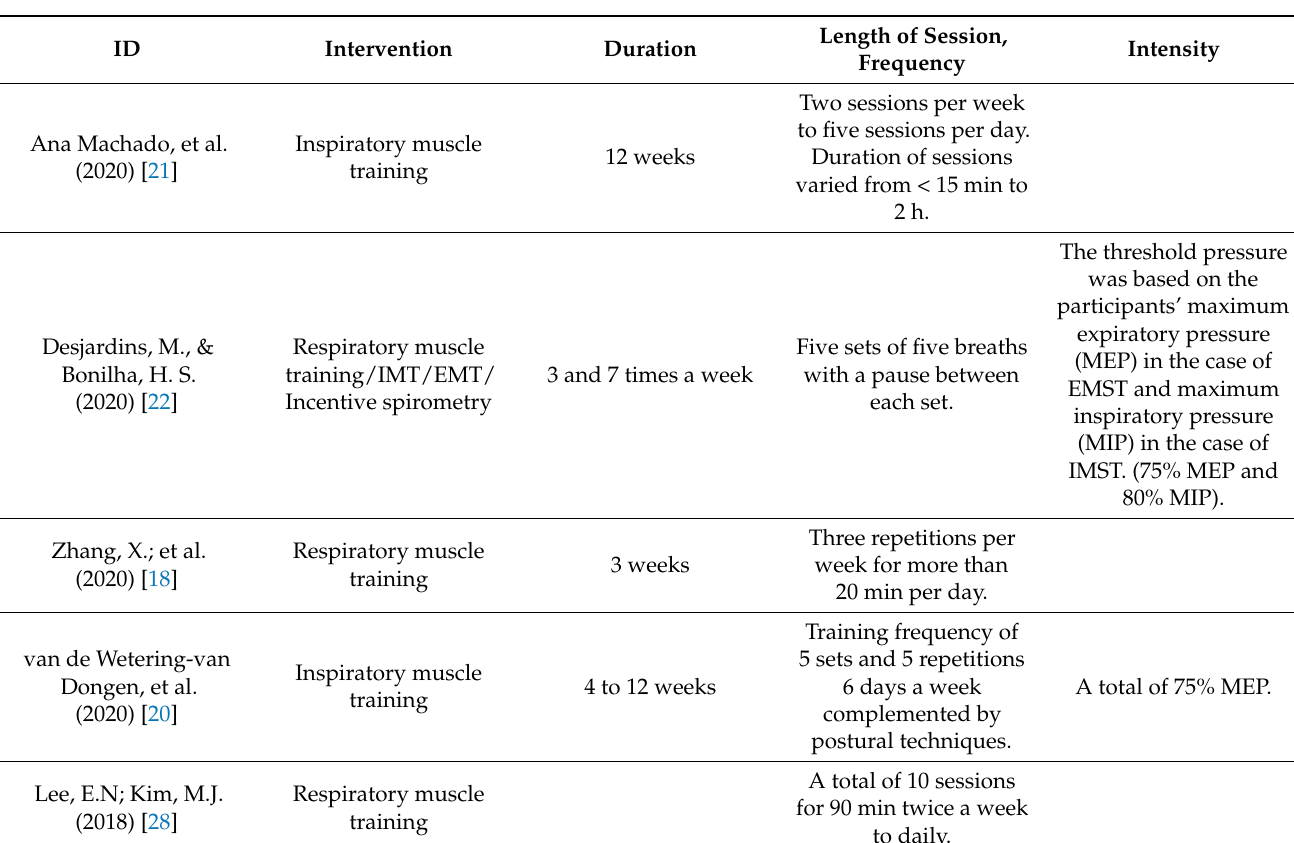
Table 2. Respiratory muscle training